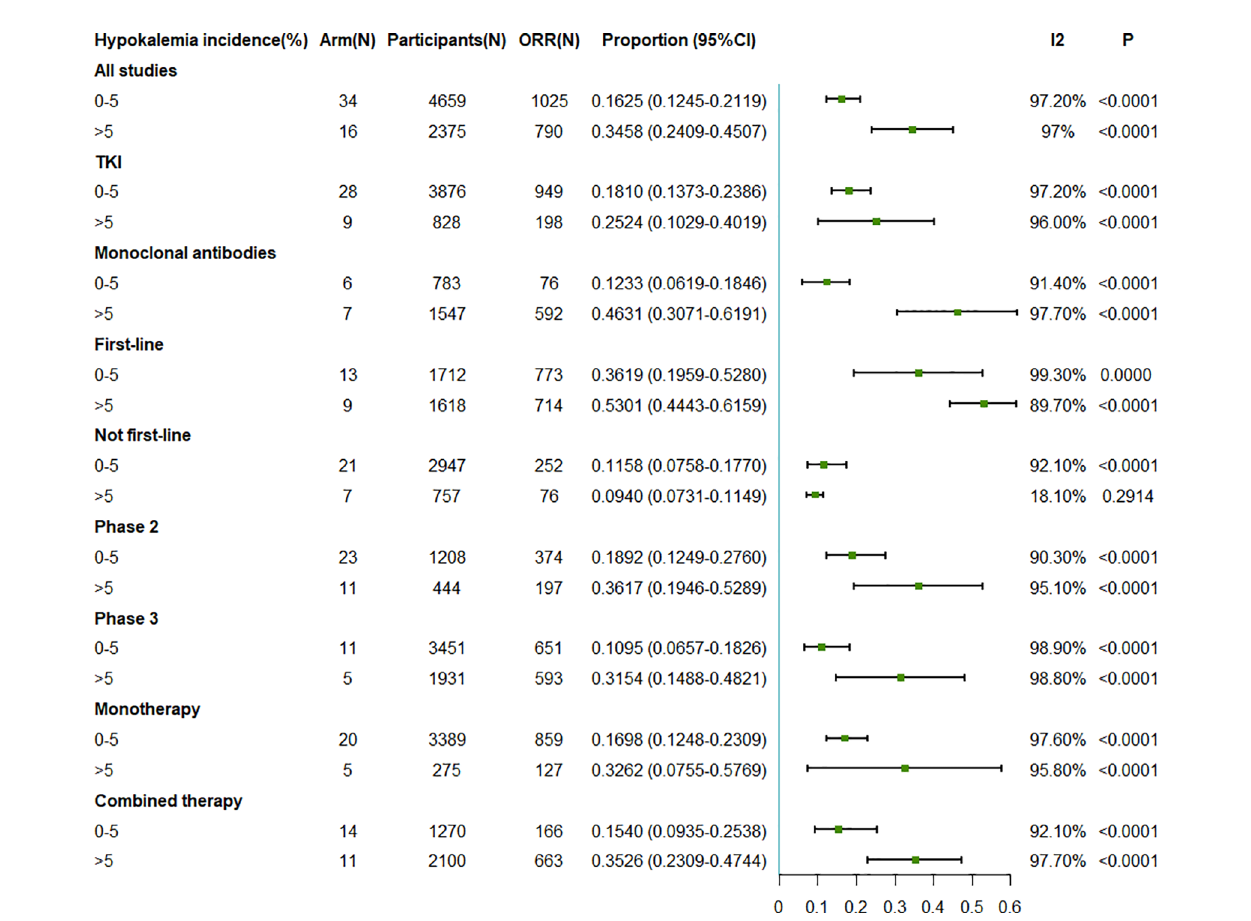
FIGURE 3 | Forest plot for the meta-analysis of the ORR of anti-epidermal growth factor receptor (EGFR) targeted therapy for different incidence rates of grade 3 – 5 hypokalemia. ORR , objective response rate; TKI , tyrosine kinase